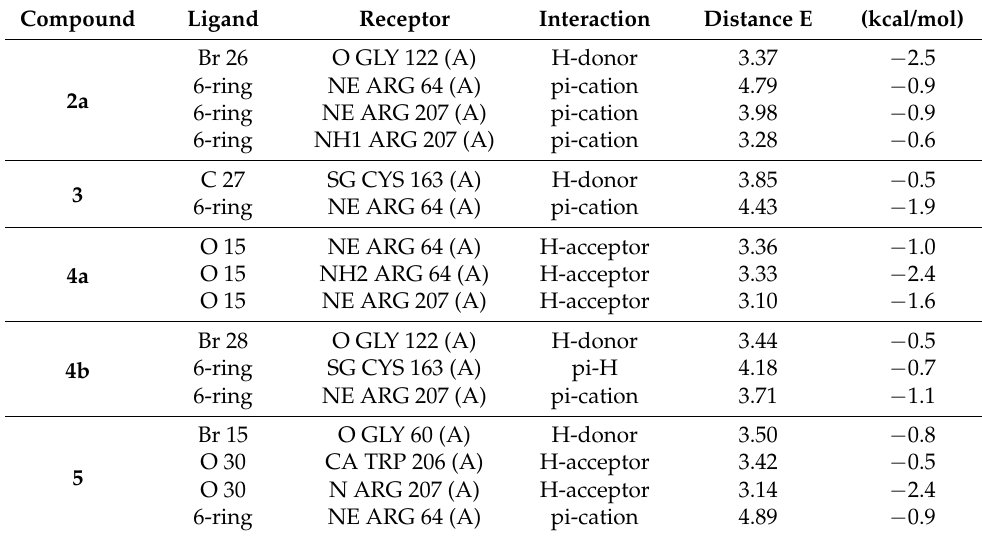
Table 7. Docking interaction of all compounds with HeLa caspase “ 3 V266 ” protein.